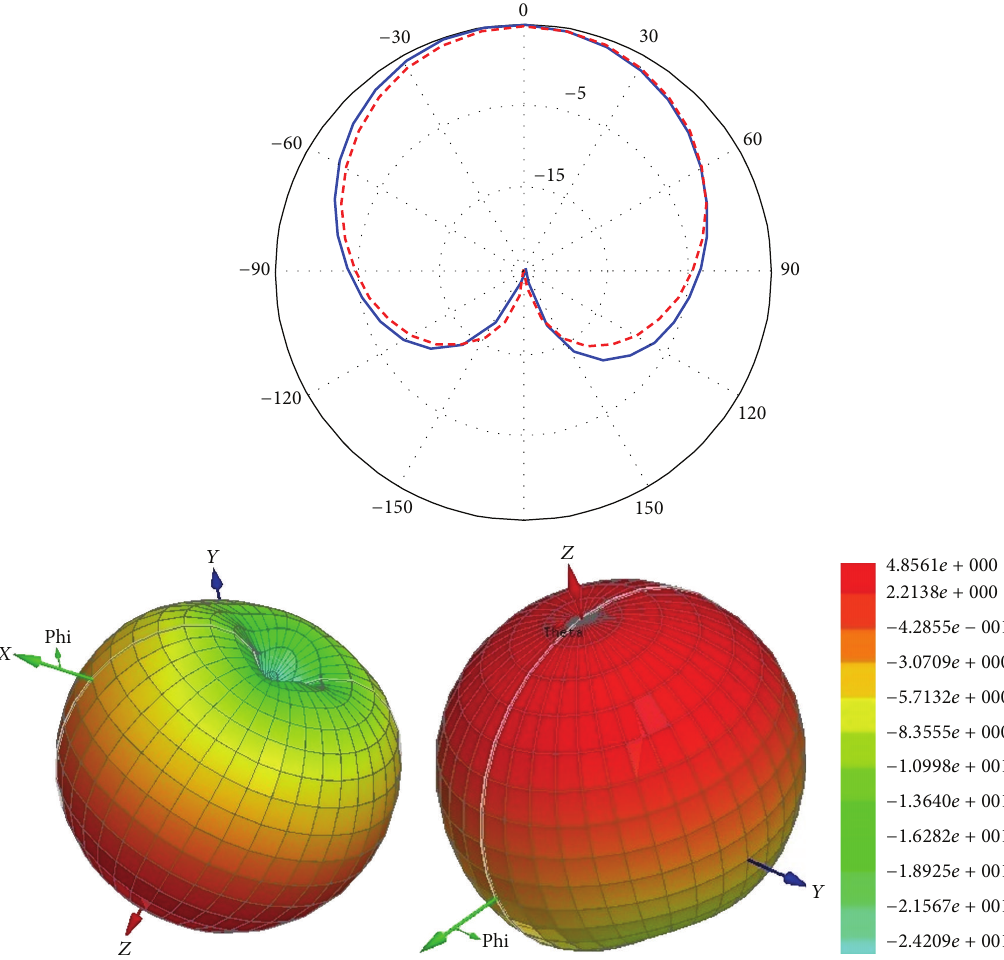
Figure 2: 2D and 3D radiation patterns of the antenna in Figure 1(b) at 6.38 GHz; ground plane size is 28 mm × 24mm ( 𝑋𝑌 ); solid line is for the E-plane ( 𝑋𝑍 ) and dashed line is for the H-plane; for clarity, two perspectives are provided in 3D case; the realized gain (dBi) is plotted.